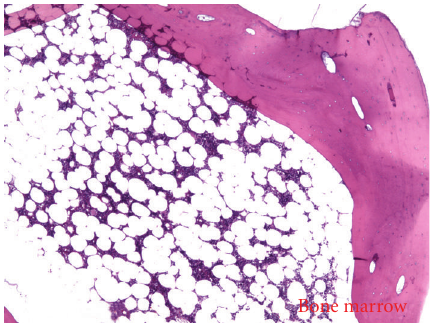
Figure 4: Bone components in teratoma.